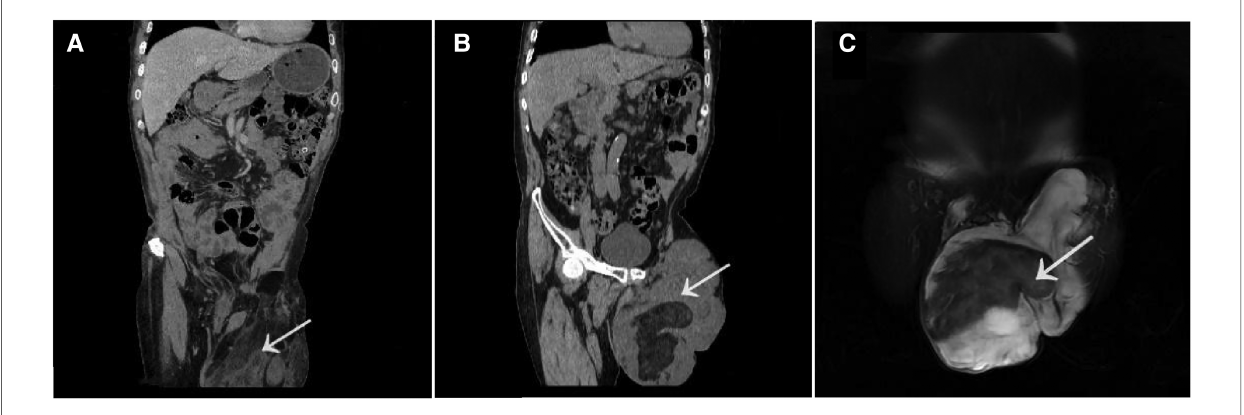
FIGURE 2 The abdominal enhancement CT showed that there was a lumpy uneven density shadow in the left scrotum, and there was fat and soft tissue density shadow In It which was not related with the contents of the abdominal cavity. After enhancement some nodules were slightly enhanced but the remaining enhancement was not found to be obvious [two years ago ( A )]. The abdominal enhanced CT showed that there was a lumpy uneven density shadow in the left scrotum again,which was about 18.5 cm×14 cm in size [now ( B )]. MRI enhancement of the pelvic cavity showed irregular mass shadow in left groin and scrotum, lobulated, with some uneven fat signal in the center, about 20 cm×13cm×17 cm in size. After enhancement, it was uneven and patchy, with arc-shaped enhancement,with no obvious changes in fat and cystic parts, clear edges, no connection between the mass and abdominal cavity ( C ). (The tumor tissue as indicated by arrowheads).